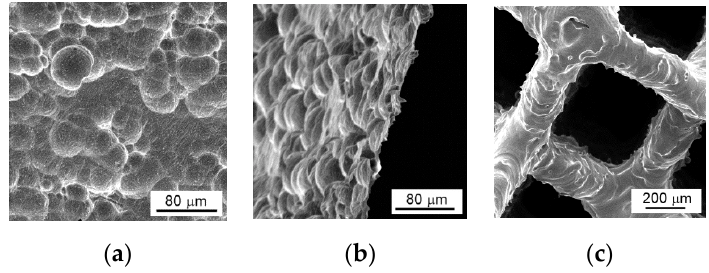
Figure 2. Specimens after 6 min etching in acids mixture: ( a , b ) compact surface (plain and side view), ( c ) trabecula beams.